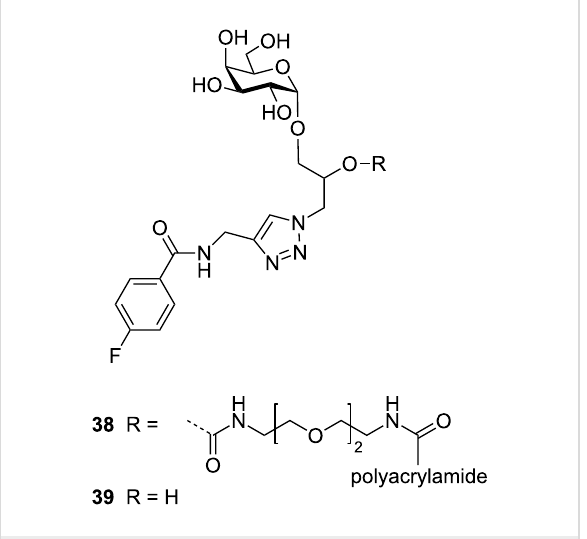
Figure 17: Hetero-bifunctional inhibitor designed by Bundle and co-workers.